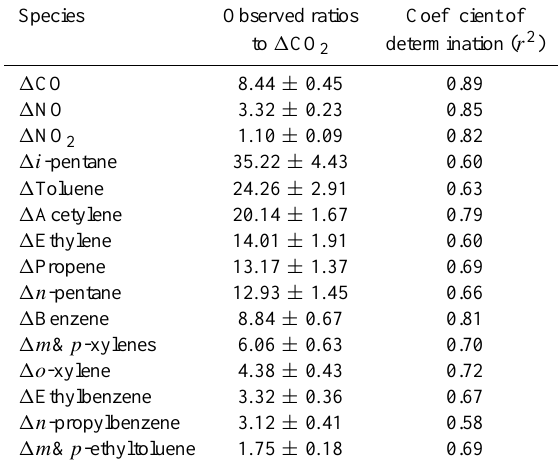
Table 1. Observed emission ratios to (cid:49) CO 2 and coefficient of deter- mination ( r 2 ). Numbers after ± signs correspond to 1 σ . Mole frac- tion ratios for (cid:49) CO, (cid:49) NO and (cid:49) NO 2 are reported in ppbppm − 1 , all others are reported in pptppm − 1 .